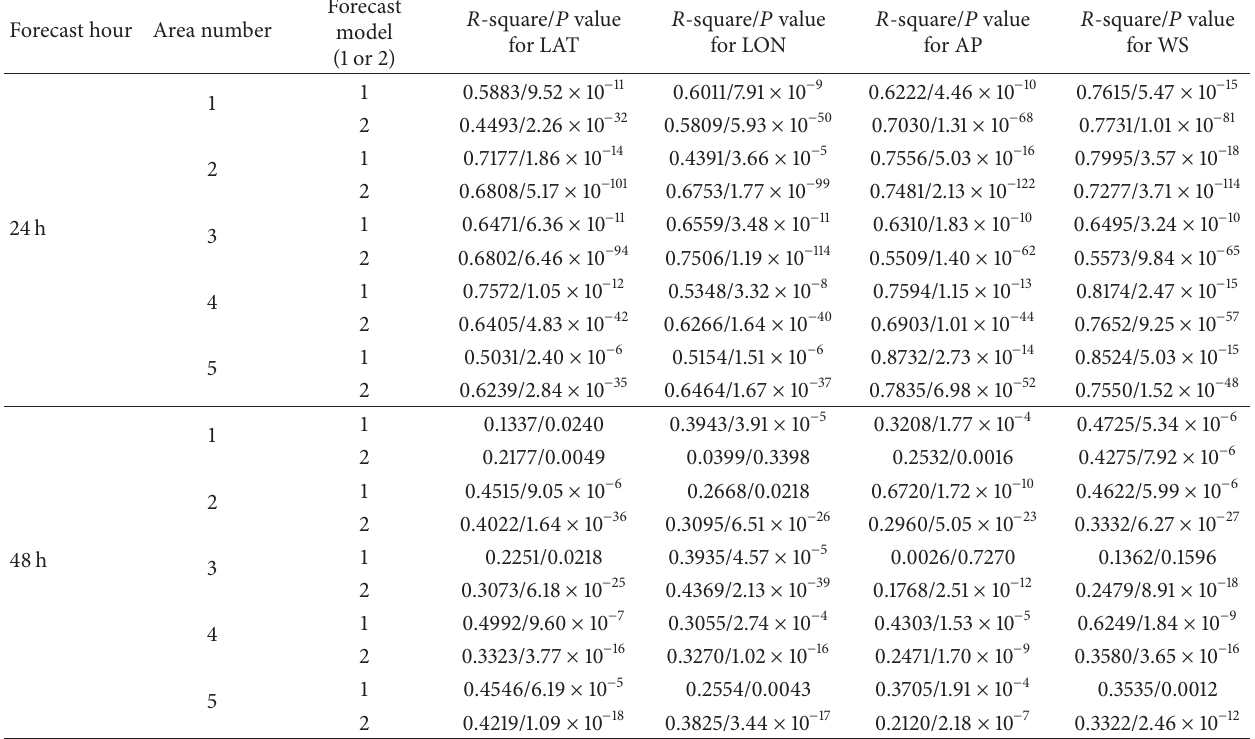
Table 9: The results of statistical significance tests for each equation used to forecast corresponding characteristic factor in forecast model 1 and forecast model